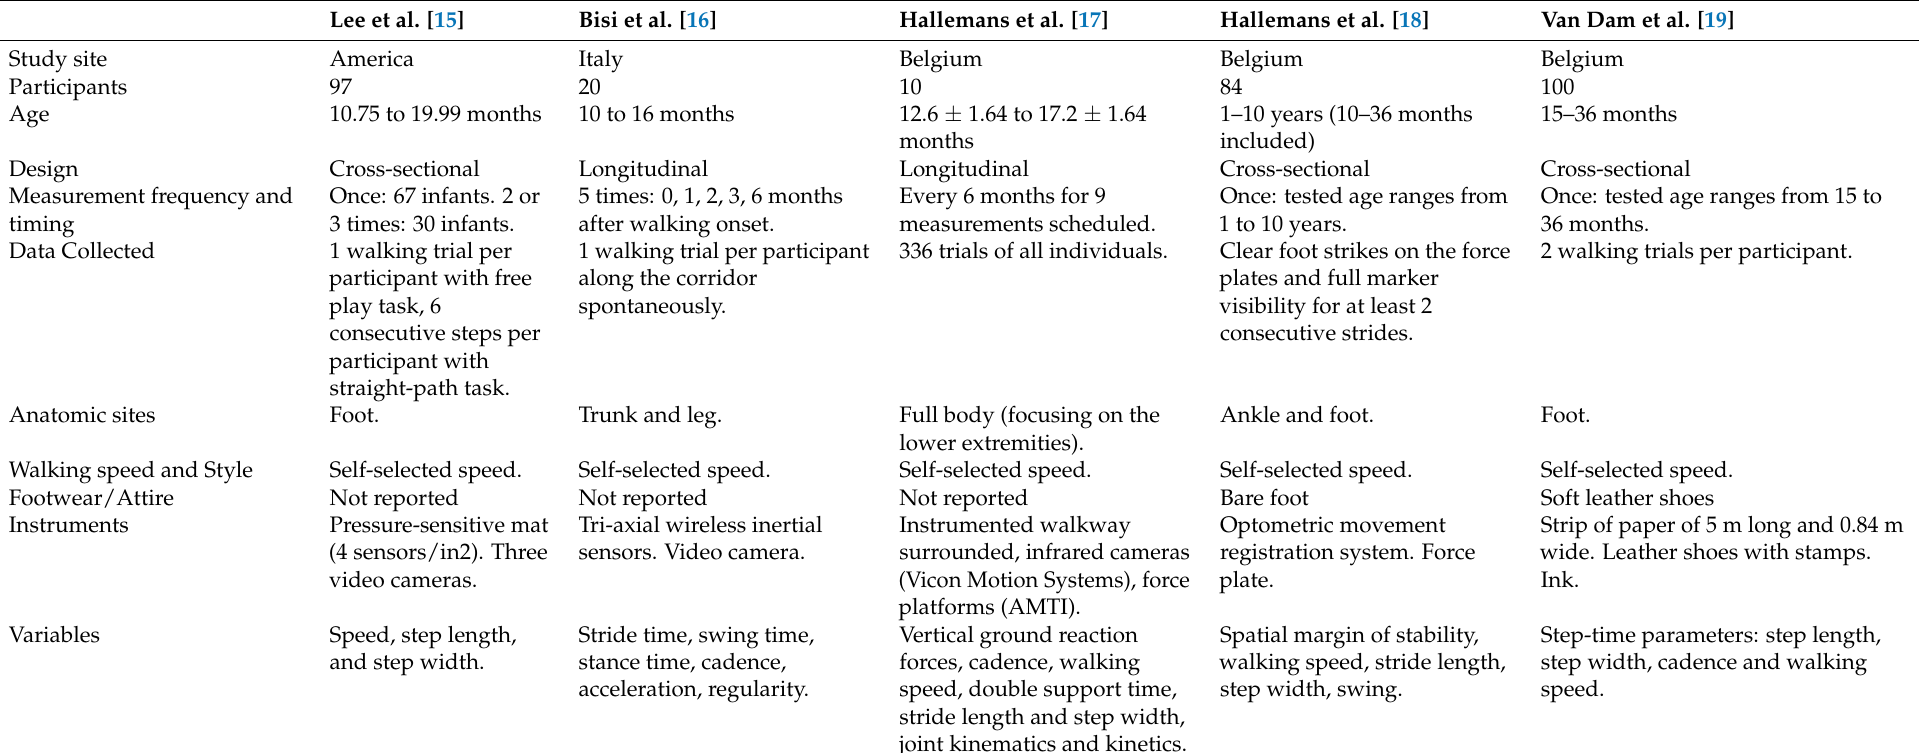
Table 1. Literature relating to spatiotemporal parameters of toddler